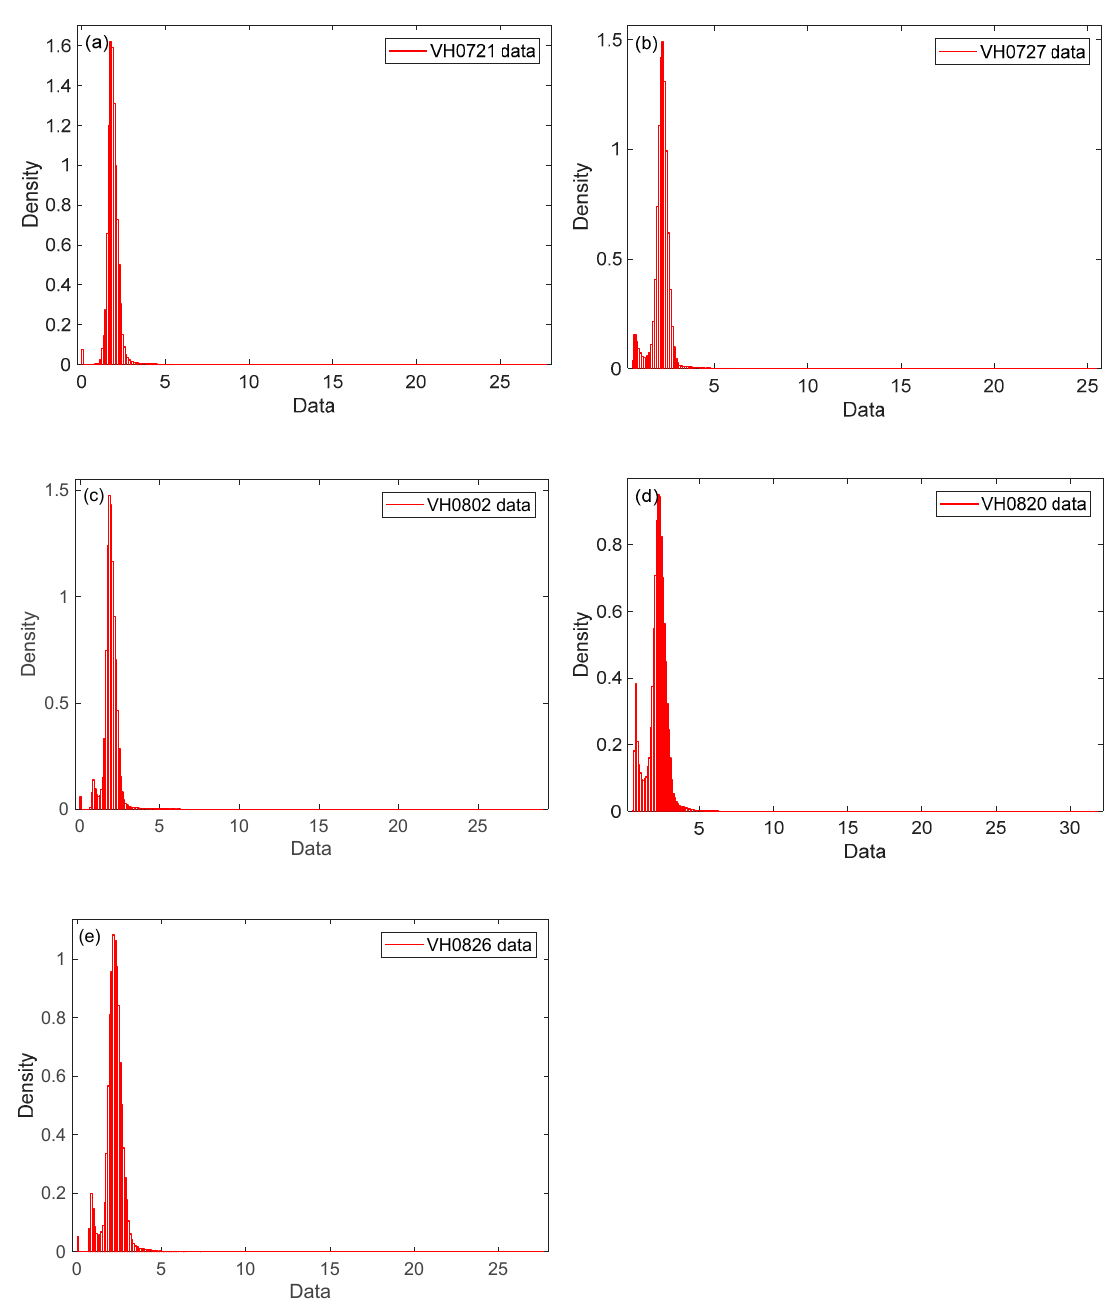
Figure 7. The histograms of five images on 21 July 2018 ( a ), 27 July 2018 ( b ), 2 August 2018, ( c ) 20 August 2018 ( d ), and 26 August 2018 ( e ). An initial binary map was generated using the Otsu thresholding based on the global image feature. Only histograms of 27 July 2018 and 20 August 2018 are bi-modal histograms, and only the contrast in gray values between flooded and non-flooded pixels is distinct. Therefore, the initial results obtained by Otsu were not good. Because Otsu relies on the image with a bi-modal histogram for proper separation, so new thresholds were generated based on partial images whose histograms were bi-modal. The inundated areas were extracted from the binary maps by removing the standing water bodies and the new results are shown in Figure 8. Except for 20 August 2018, the binary maps were all new. Although the results were improved a lot, the errors were still large. Except for the image on July 21, 2018, the river was extracted well, but there was a lot of noise. The farmland was barely inundated on July 27, August 20, and August 26, 2018.